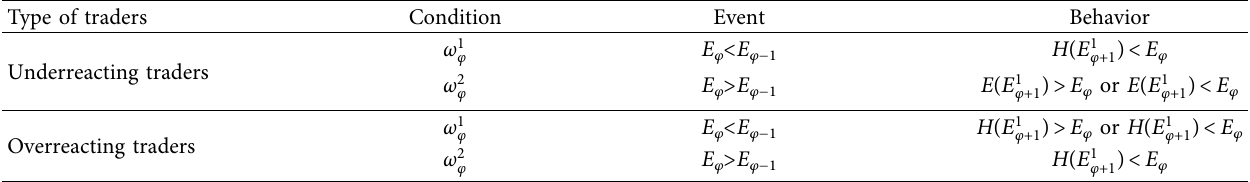
Table 1: Behaviors of different types of